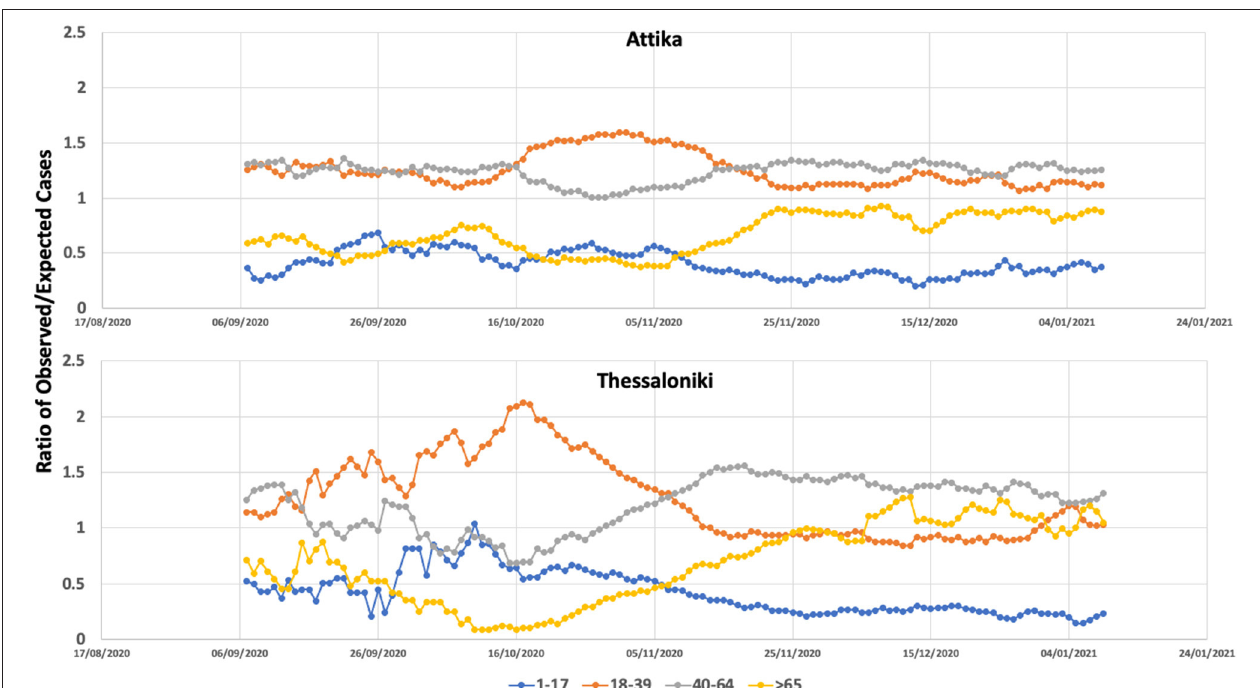
FIGURE 3 | Ratio of observed versus expected number of COVID-19 cases within the age groups of 0–17, 18–39, 40–65, and > 65 in Attika and Thessaloniki between September 2020 and January 2021.